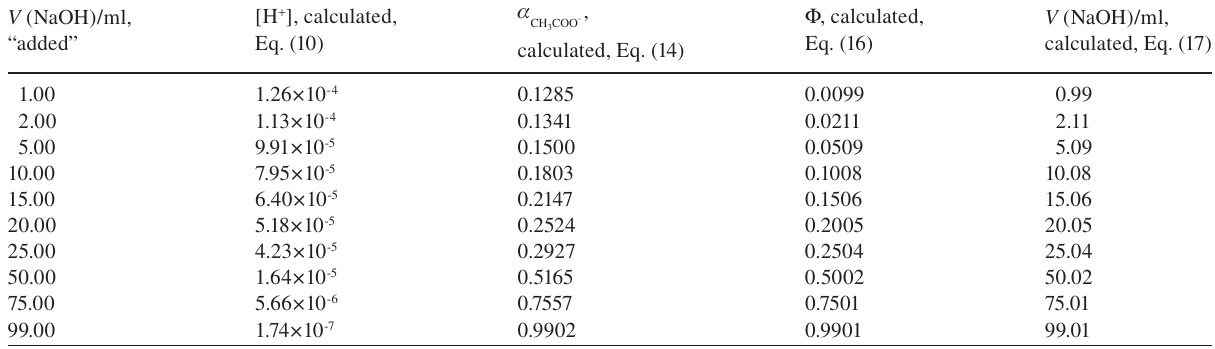
Table 2 Comparison between “ added ” and calculated volume of titrant for acetic acid (0.0010 M) vs. sodium hydroxide (0.0010 M)